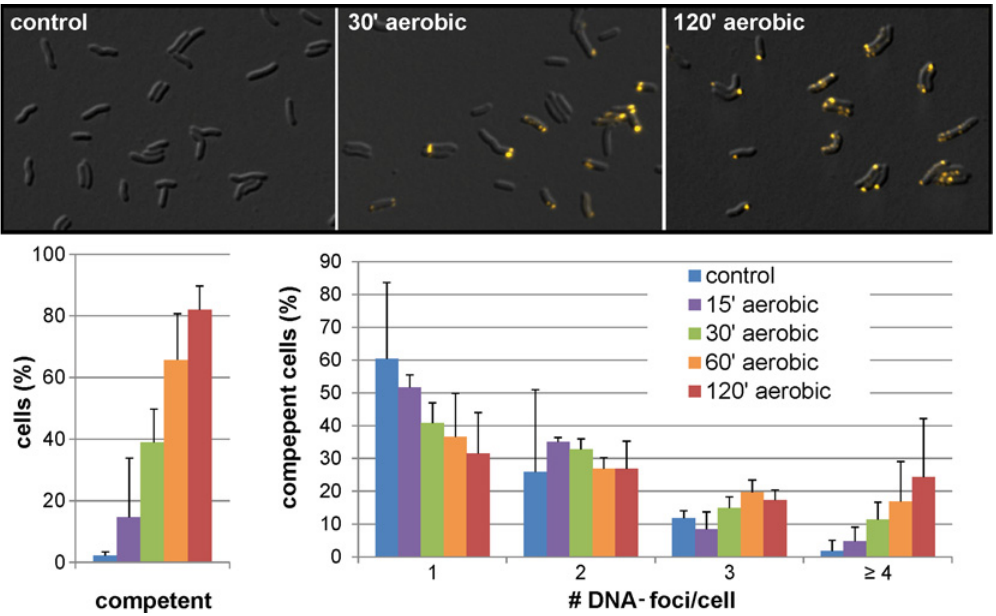
Fig 5. Kinetics of competence development under aerobic conditions. H . pylori N6 was grown microaerobically in BB-FBS overnight at t0 before competence development (OD 600 ~0.2). Cells were exposed to aerobic conditions at 37°C for 120 min. At the indicated time points the competence fraction of the cells was monitored. Control cells were kept under microaerobic atmosphere. Upper panel, DIC/Cy3 images of bacteria at indicated timepoints, with DNA stained in yellow; lower panel (left), fraction of competent cells; lower panel (right), number of distinct DNA foci per competent cell. Data stem from at least three experiments; error bars, standard deviation.